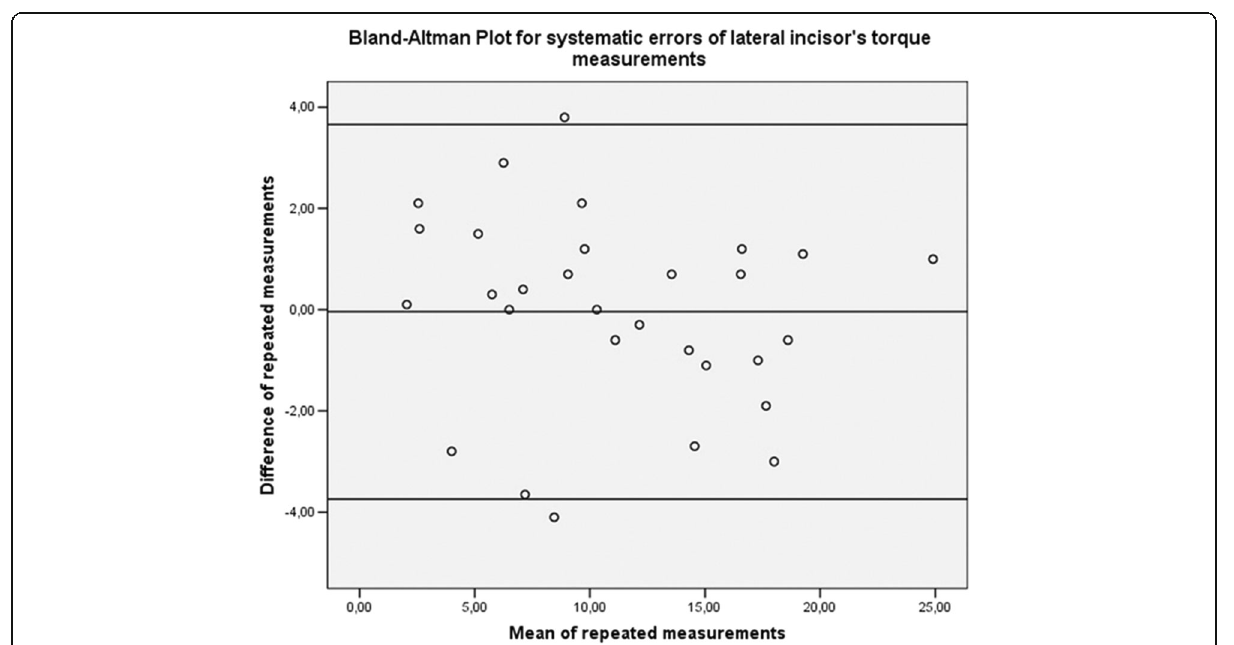
Fig. 3 Bland – Altman plot for repeated measurements of lateral incisors, confirming the absence of systematic